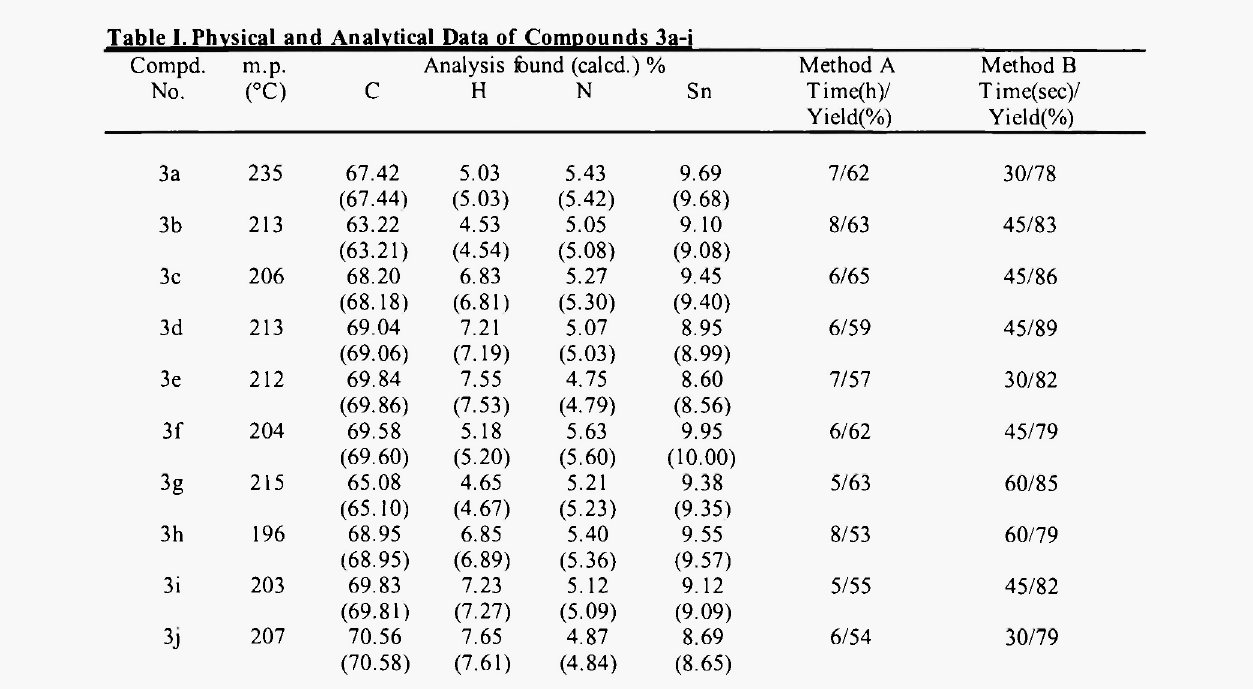
Table I. Physical and Analytical Data of Compounds 3a-i